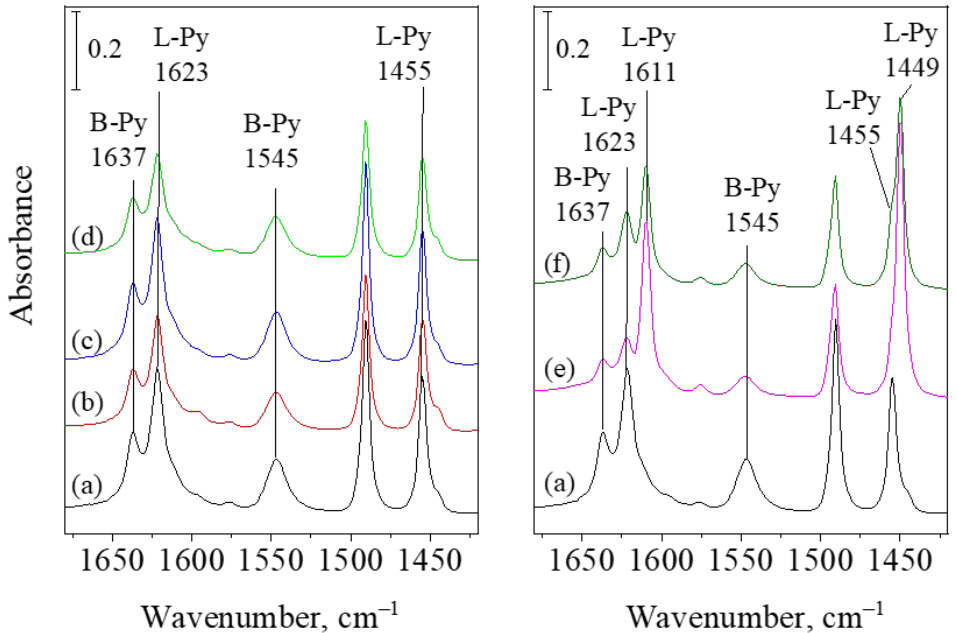
Figure 7. FT-IR spectra of adsorbed pyridine on the studied catalysts: ( a ) parent zeolite Beta, ( b ) 1Pt/HB ( c ) 5Ru/HB, ( d ) 5Ru1Pt/HB, ( e ) 10Ni/HB, ( f ) 10Ni1Pt/HB. Py (6 mbar) was adsorbed on 400 °C dehydrated samples at 200 °C and desorbed at 200 °C in high vacuum.